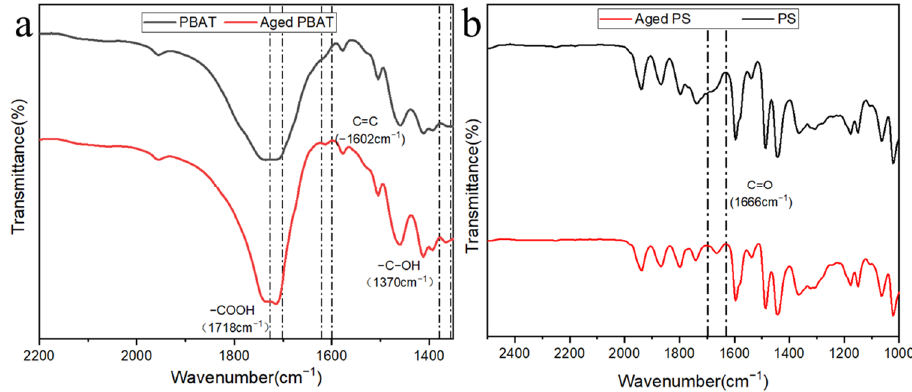
Figure 2. FTIR spectra before and after UV aging and adsorption (( a ) PBAT and ( b ) PS).